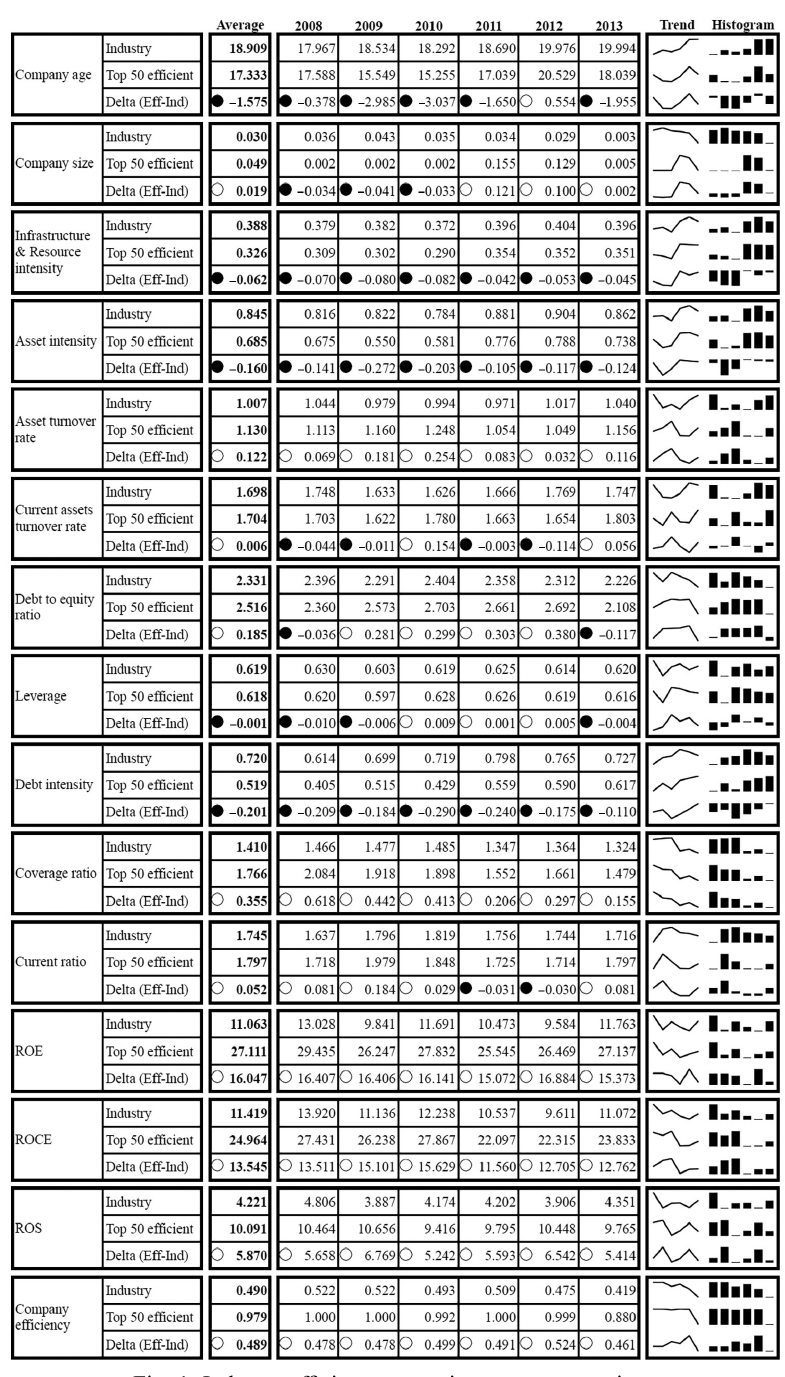
Fig. 1. Industry-efficient companies group comparison Source :